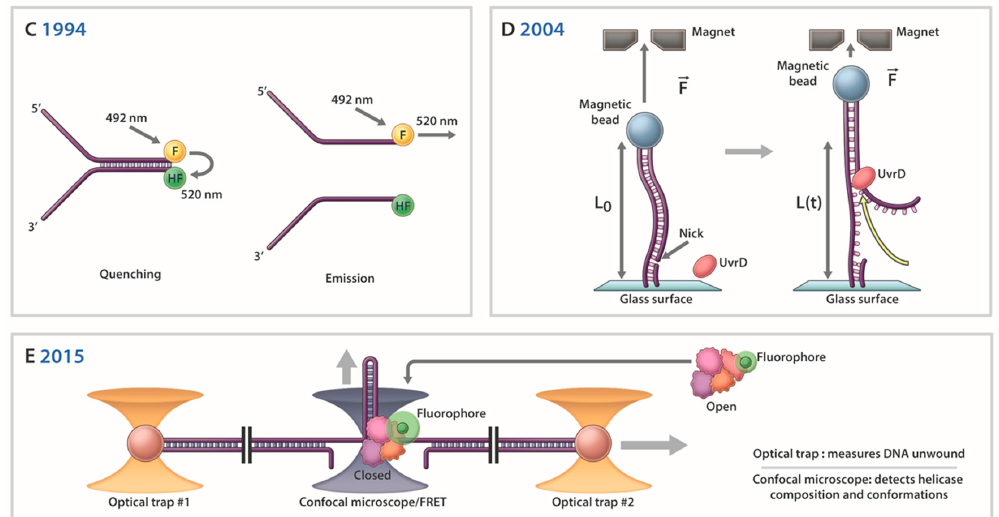
Figure 2. Representative assays to measure helicase-catalyzed DNA unwinding. Dates of published papers using the depicted techniques are indicated in blue font. ( A ) S1 nuclease digestion assay to measure DNA helicase activity. In the example shown, products from helicase reactions containing duplex [ 32 P] DNA are incubated with single-strand-specific S1 nuclease and precipitated with